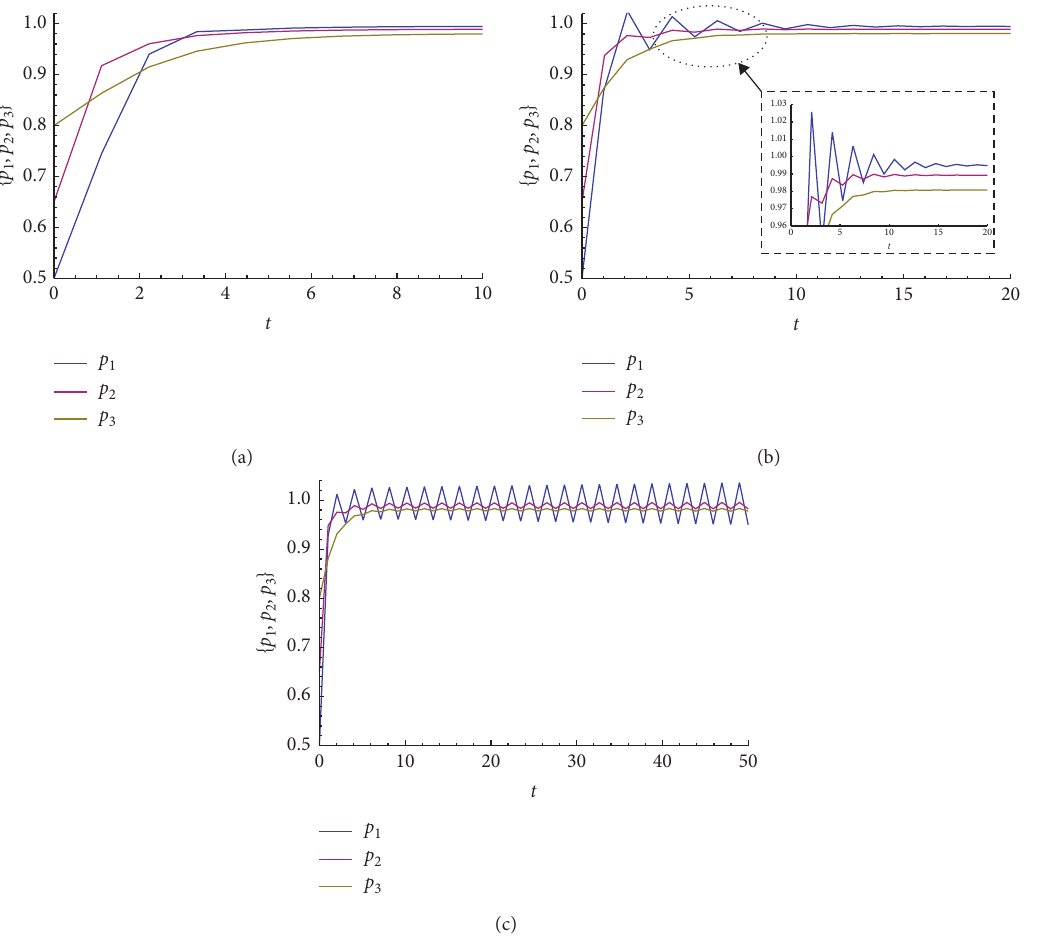
Figure 3: p , p , p trajectory change with time at different adjustment speeds of enterprise 1. (a) α � 0 . 4. (b) α � 0 . 6. (c) α � 0 . 1 2 3